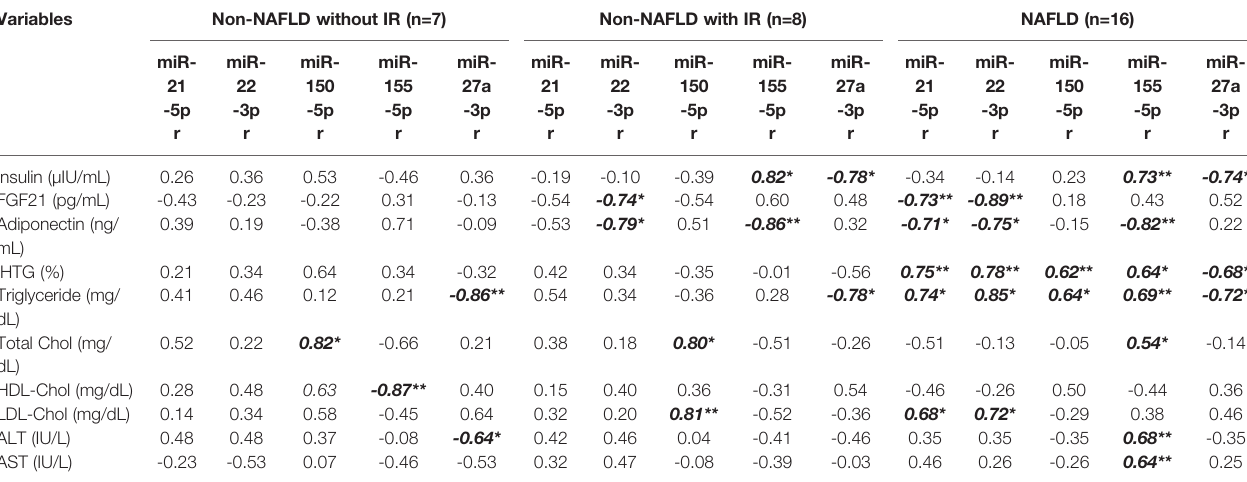
TABLE 2 | Correlation analysis between serum miRNAs and metabolic markers among the groups.